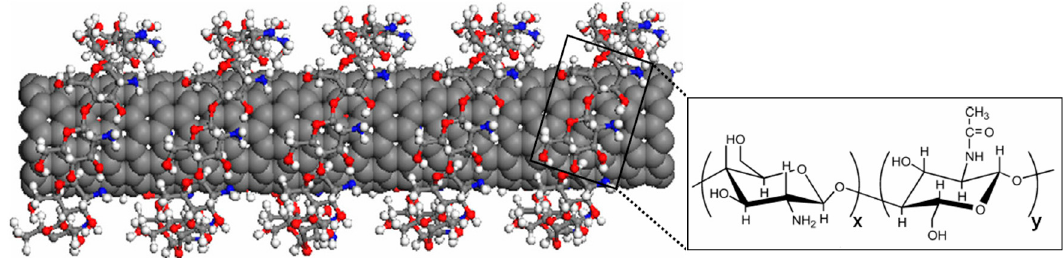
Figure 2. Schematic illustration of chitosan helically wrapping around the outside of a CNT. The structure of chitosan is also shown. Reproduced with permission from Reference [30]. Copyright Elsevier, 2007.